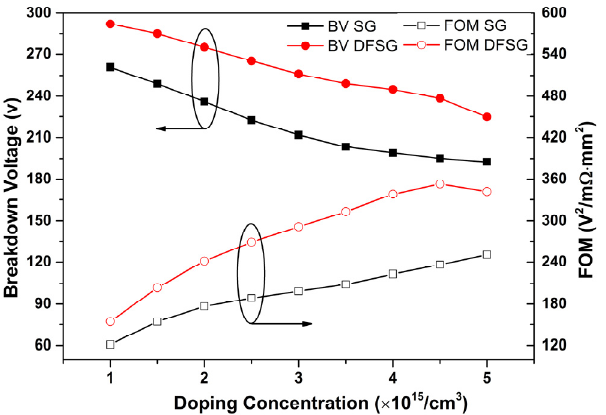
Figure 6. Dependence of the breakdown voltage (BV) and figure of merit (FOM) (BV 2 / R SP ) on the doping concentration of n-drift for SGRSO and DFSGRSO UMOSFETs. Table 1. Device parameters for the comparison of simulations.